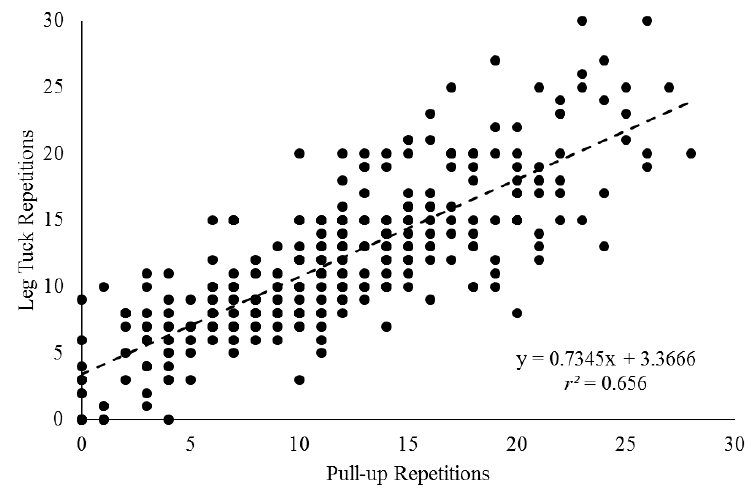
Figure 2. Regression scatter plot for firefighter trainees ( N = 305) between leg tuck and pull-up repetitions.